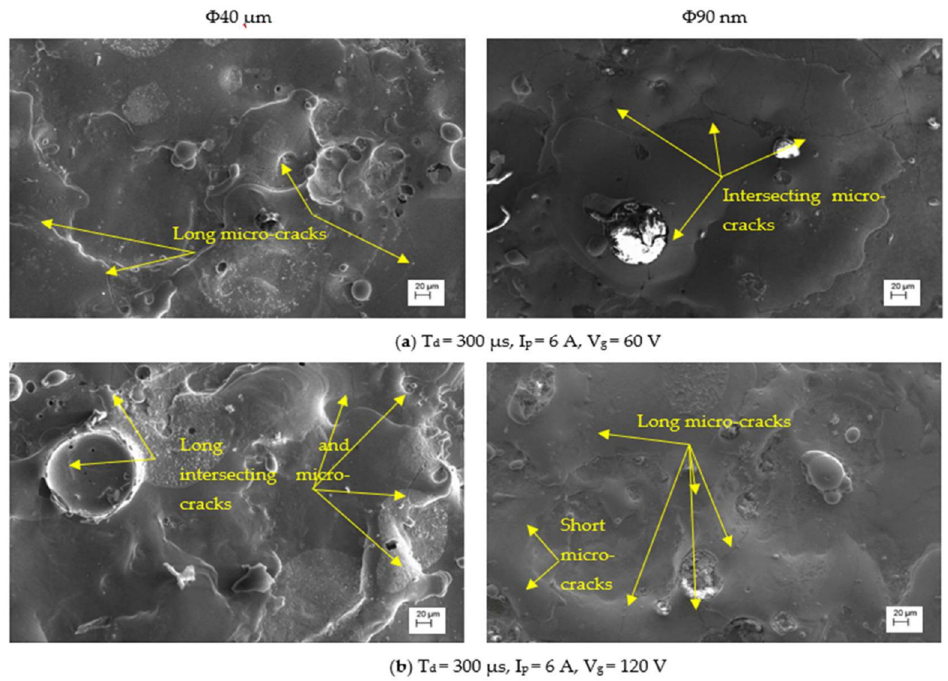
Figure 17. SEM micrographs with variation of gap